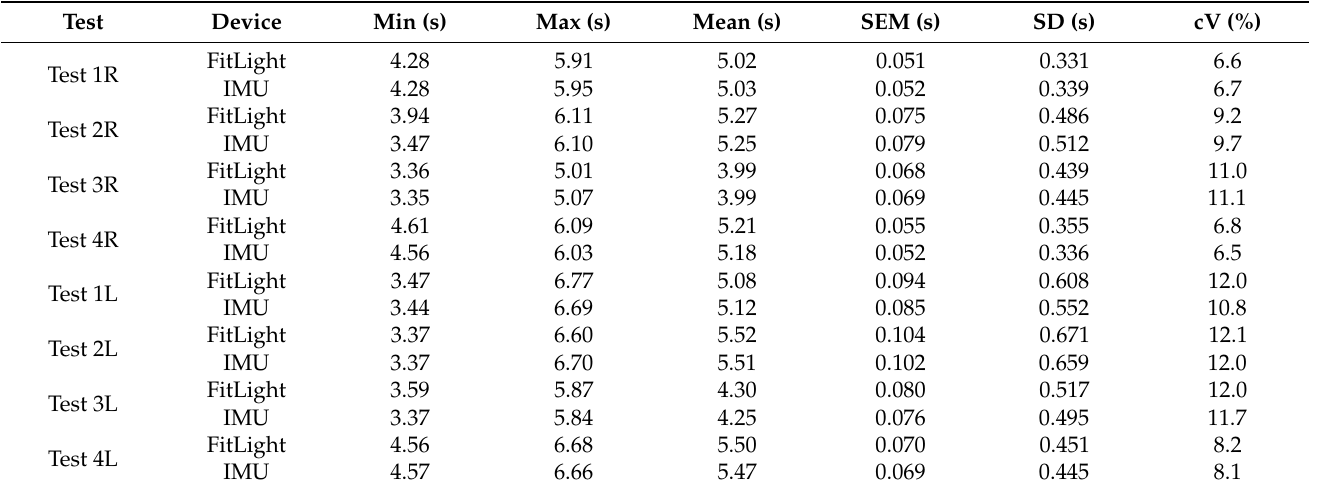
Table 1. Descriptive statistics 1 for all four tests and both legs ( N = 42 for each